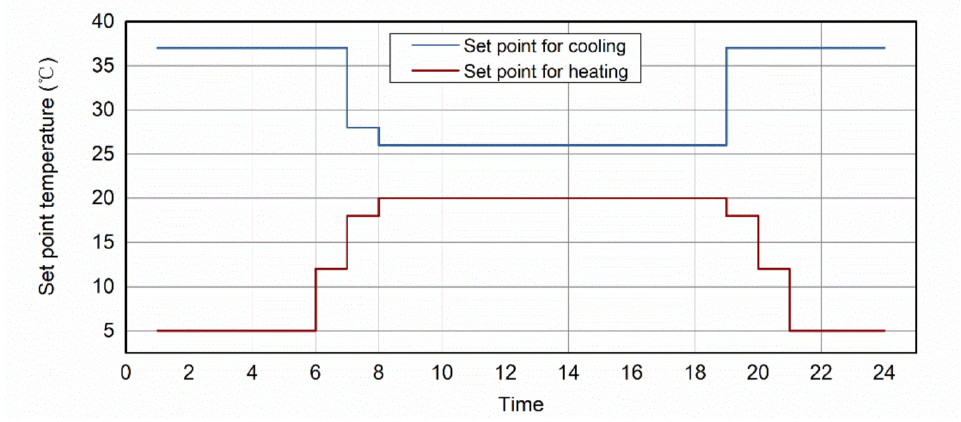
Figure 4. Thermostat action points for heating and cooling.